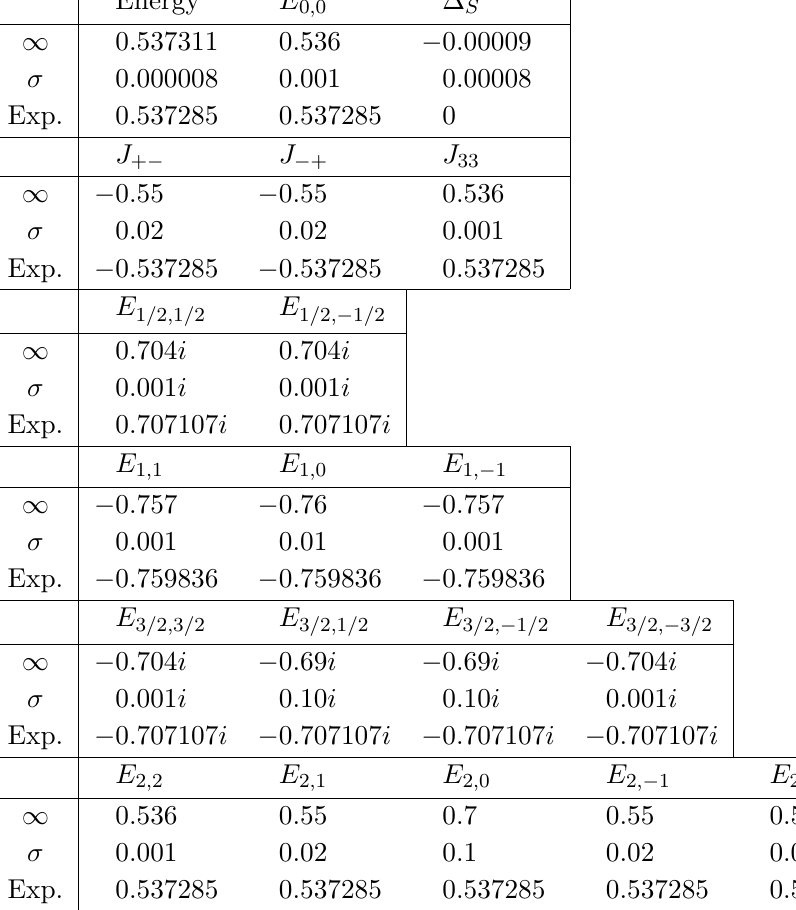
Table 7 . Extrapolations of gauge invariants of a solution describing 0-brane with θ = π/ 2 in the k = 4 model with J = 1 boundary